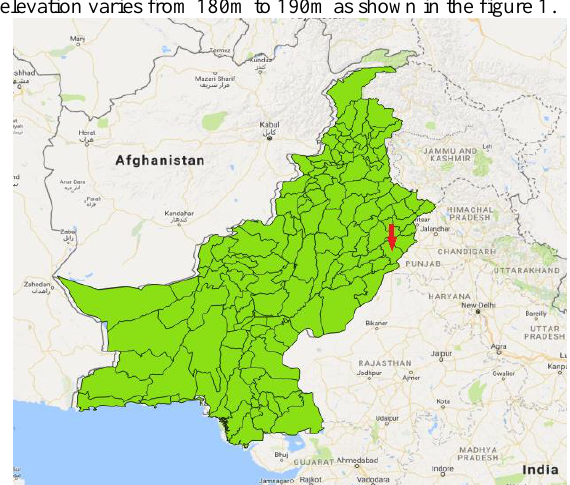
Figure 1. Study-site of Nestle-Pakistan’s Sar-Sabz Farms Renla-